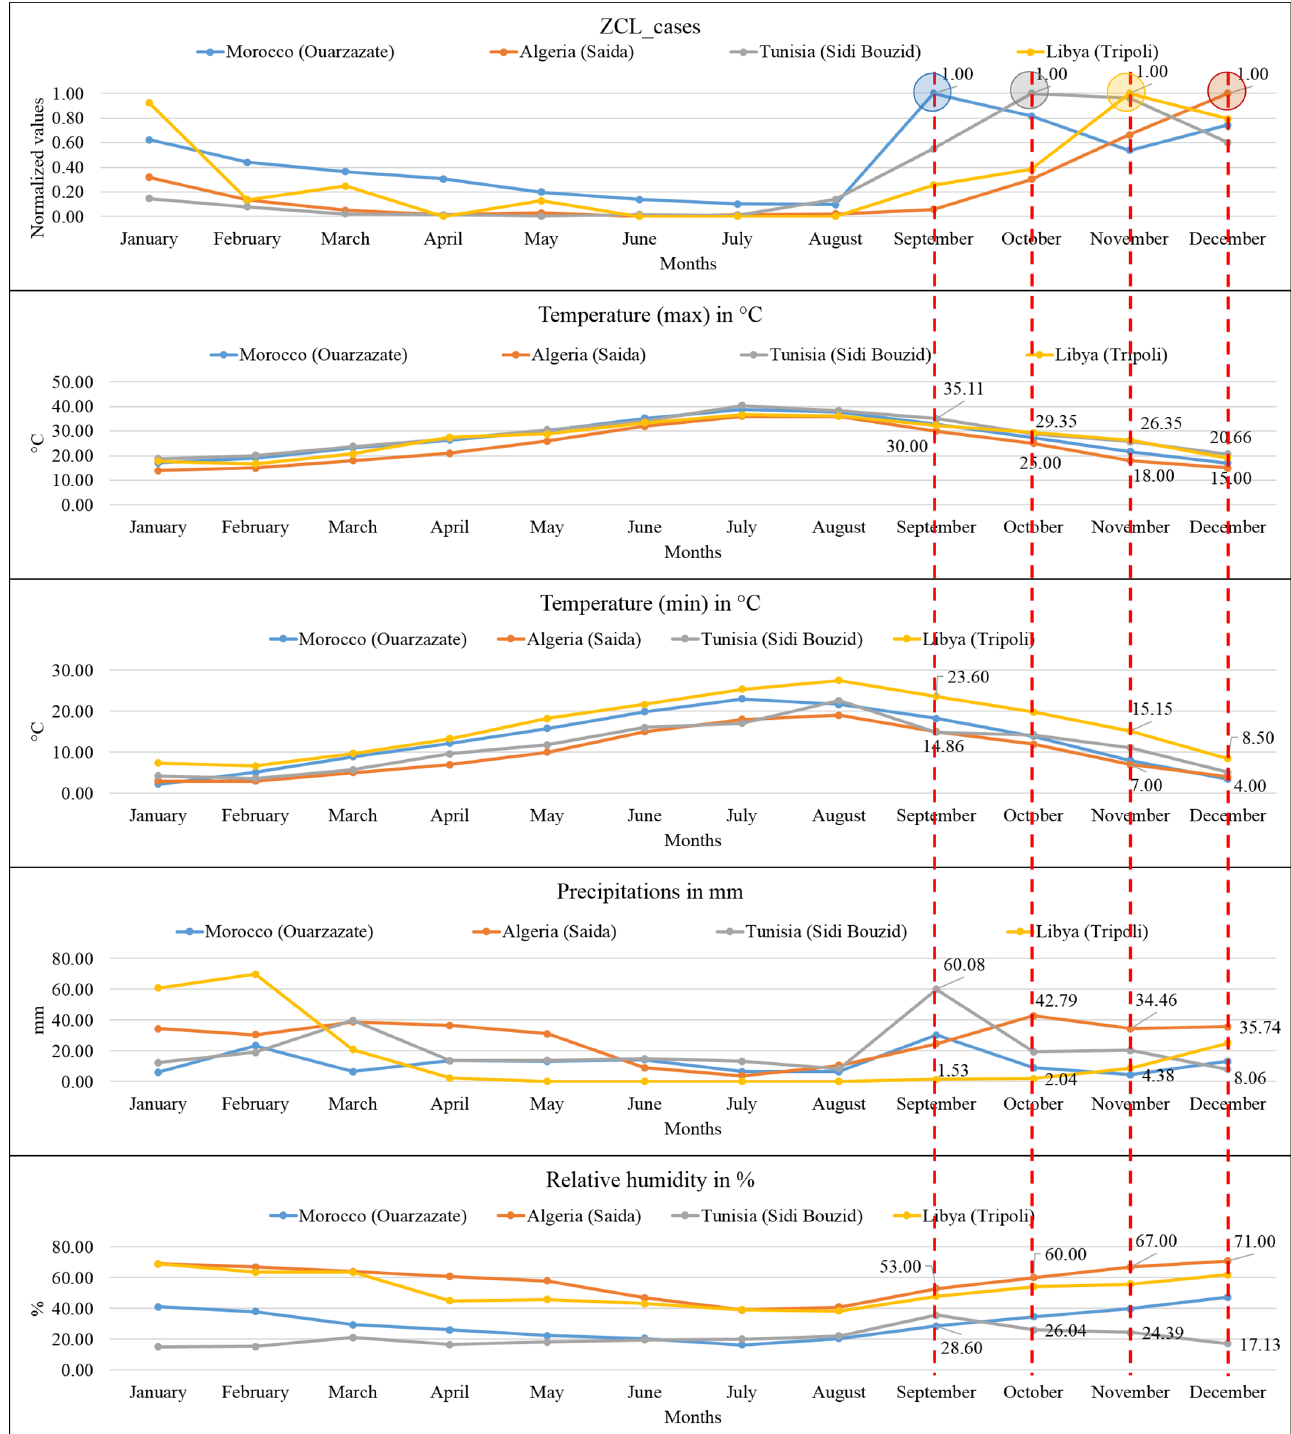
Figure 8. Association between seasonal ZCL incidence and the climatic parameters. Red dotted lines indicate the association between the peaks of ZCL cases and climatic parameters.